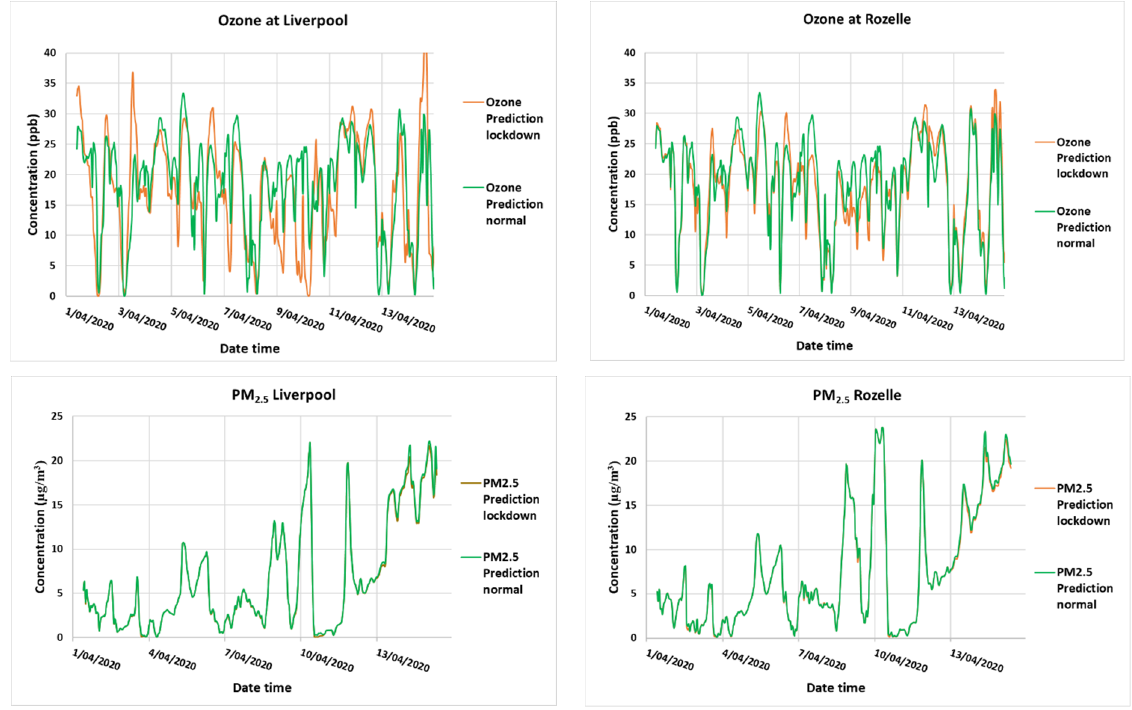
Figure 14. CO, NO 2 , O 3 , and PM 2.5 prediction from 1 to 14 April 2020 at Liverpool and Rozelle during the lockdown with 30% less traffic emission and with normal traffic emission.